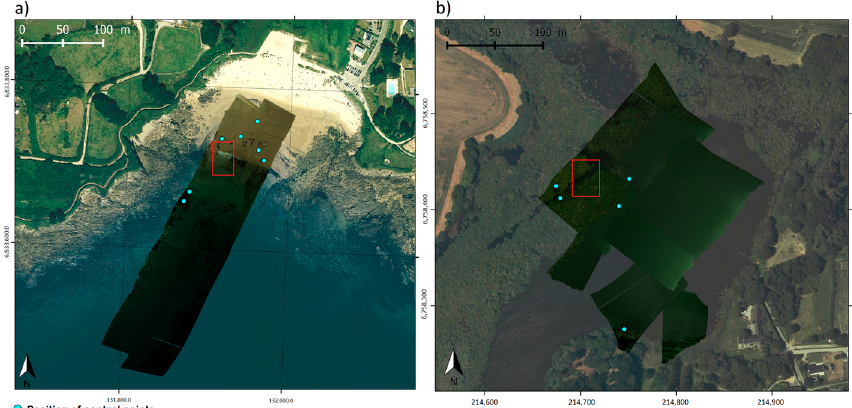
Figure 7. Results of hyperspectral lines georegistration at Porsmilin Beach ( a ) and at Lannénec Pond ( b ). The blue spots display the position of the control points. The red rectangles indicate the zones corresponding to the hyperspectral cubes displayed in Figure 8.